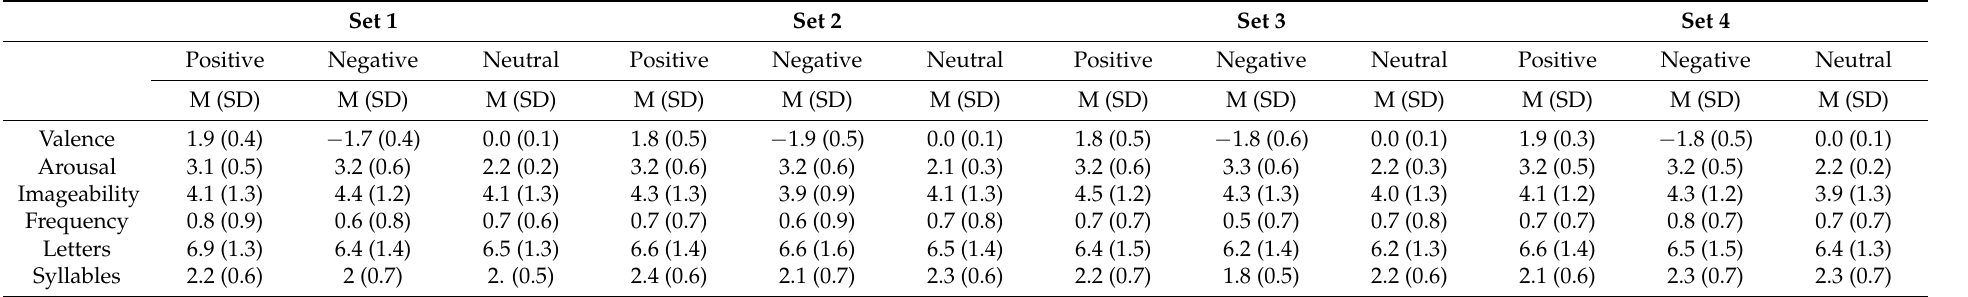
Table 1. Stimulus characteristics used in the four parallel versions of the emotional n-back (EMOBACK)